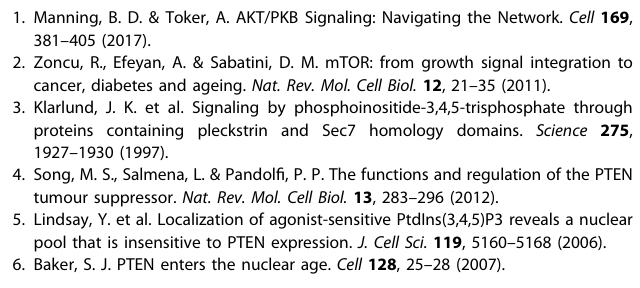
Fig. 1 PTEN suppresses tumorigenesis by directly dephosphorylating Akt. a Sequence comparison of PTEN gene in different species. The phosphorylation motifs of Akt are highlighted in red. b Whole-cell lysates of 293T cells were collected, immunoprecipitated with indicated antibodies (IP) and subjected to immunoblotting (IB) analysis. c 293T cells were transfected with vector, Flag-Akt1, or Flag-PTEN. The cell lysates were prepared for IP and IB analysis. d 293T cells were transfected with GFP-PTEN and RFP-Akt1 separately or together. IF assays were performed. Scale bar is 10 μ m. e 293T cells were collected or transfected with vector or Flag-PTEN, then cells were subjected to IP and IB analysis. f 293T cells were co-transfected with vector or Flag-PTEN and Myc-Akt1, Myc-Akt1-T308A-S473A, or Myc-Akt1-T308D-S473D. Cells were subjected to IP and IB analysis. g 293T cells were transfected with RFP-Akt1 alone or together with Flag-PTEN, Flag-PTEN-G129E, Flag- PTEN-Y138L, or Flag-PTEN-C124S respectively, or co-transfected with RFP-Akt1, Flag-PTEN-G129E, and Myc-PTEN-Y138L. The cells were serum- starved for 18 h, and then treated with insulin (1 μ g/ml) or EGF (100 ng/ml) for 10 min before being subjected to IF assays. Scale bar, 10 μ m. h 293T cells were transfected with vector, Flag-PTEN, Flag-Akt1, Flag-PTEN-G129E respectively, immunoprecipitated with anti-Flag agarose, respectively, immunoprecipitated with anti-Flag agarose, and eluted with 3× Flag peptide. The puri fi ed proteins were subjected to phosphatase assays. j The nuclear and cytoplasmic fraction of 293T cells were extracted and immunoprecipitated with PTEN antibody. The